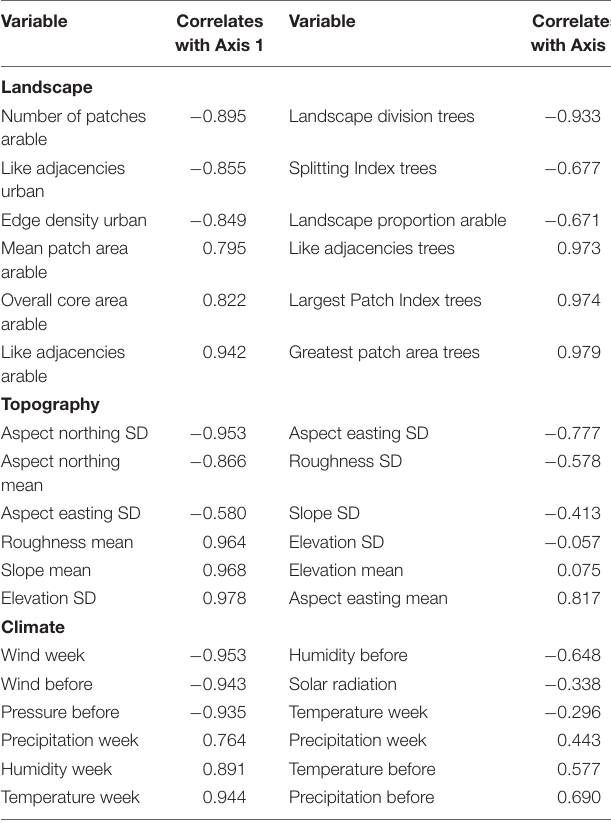
TABLE 1 | Main correlates between landscape, topographic, and climatic metrics analyzed using Principal Components Analysis and the first two PCA axes in each